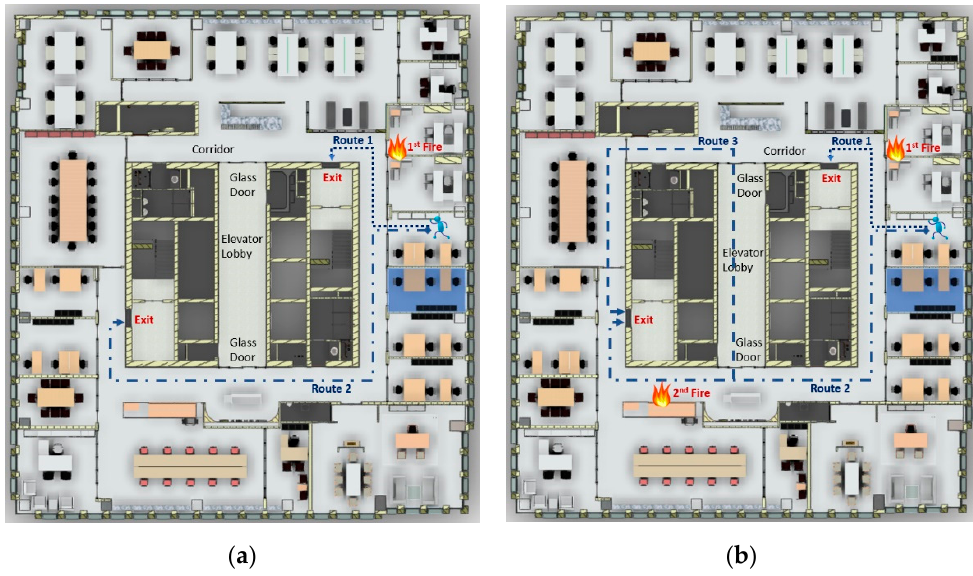
Figure 7. Evacuation route selection in ( a ) Scenario 1 and ( b ) Scenario 2.